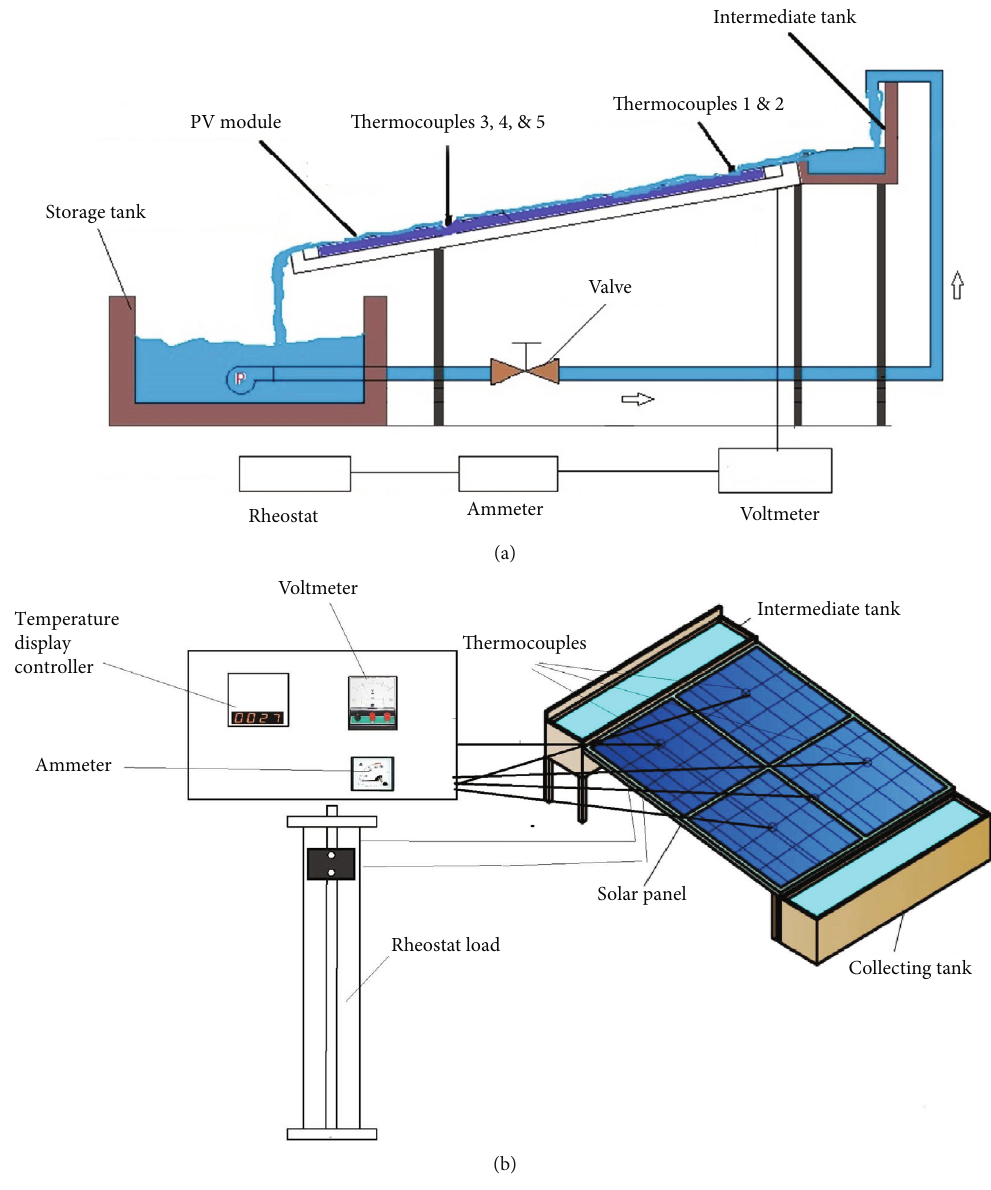
Figure 1: (a) Schematic diagram of experimental setup; (b) top view of the experimental setup.